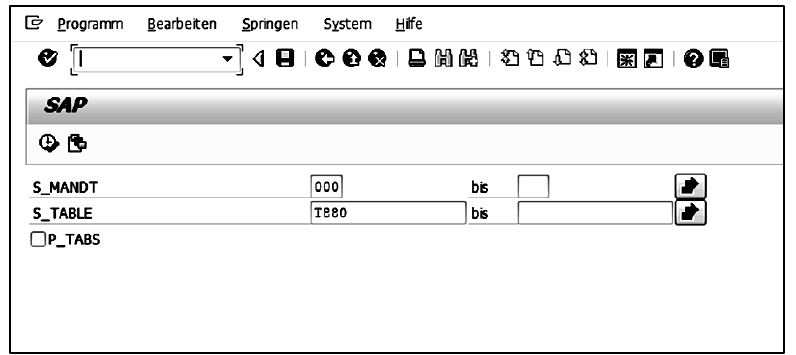
Figure 1. Start Screen of Identify High Complexity